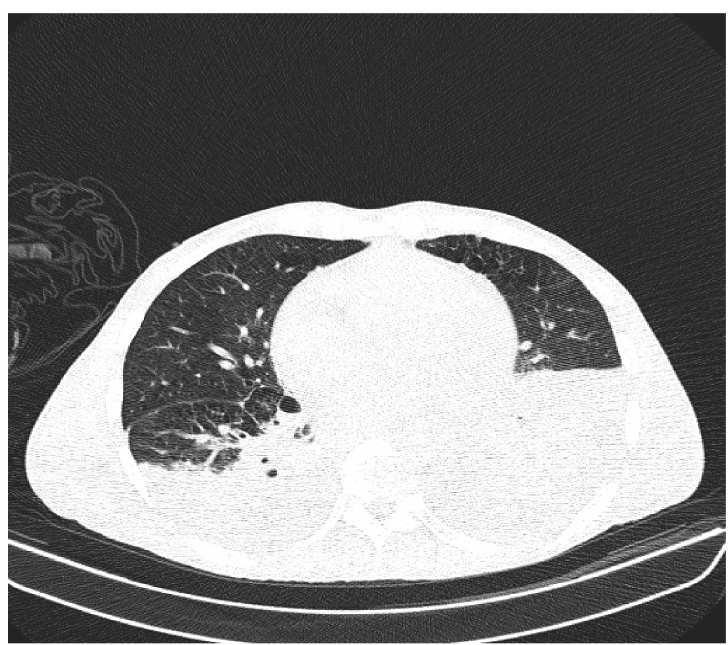
Figure 6. Patient’s computer tomography: no fluid accumulation